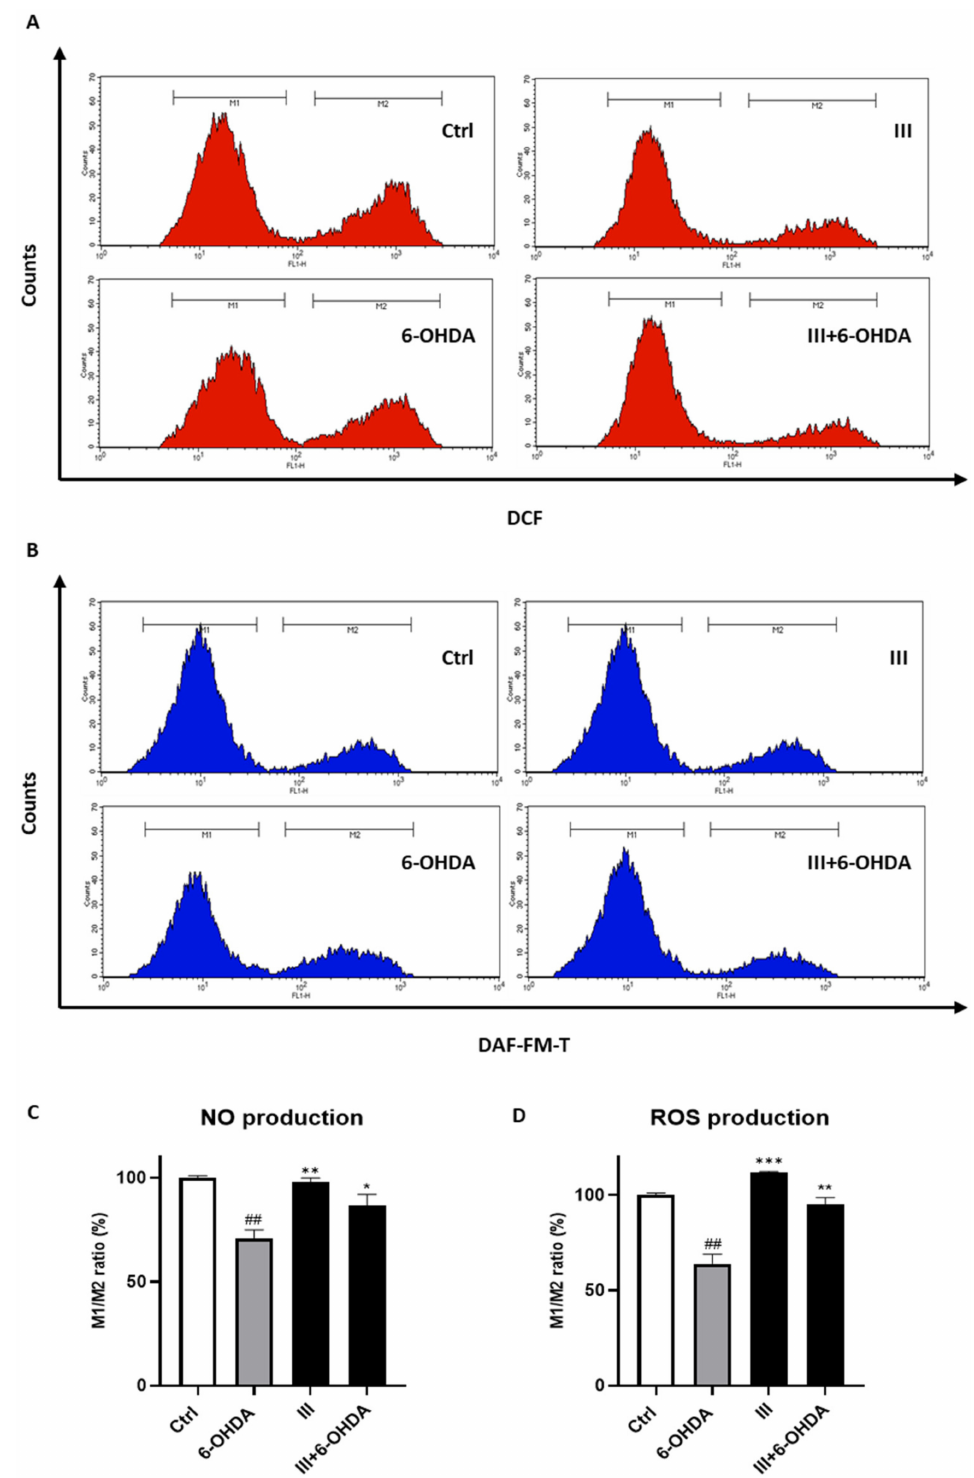
Figure 6. Effect of fraction III (6 µ g/mL) on ROS ( A , D ) and NO production ( B , C ), evaluated by DCFH-DA and DAF-FM, respectively, via cytofluorimetric analysis on SH-SY5Y cells treated with 6-OHDA (50 µ M). Data are expressed as % of M1/M2 ratio (M1 = healthy population M2 = ROS/NO population). Results are showed as mean ± standard deviation (SD) from three independent ex- periments. ## denotes p < 0.01 vs. Ctrl; *, ** and *** denote respectively p < 0.05, p < 0.01 and p < 0.001 vs.